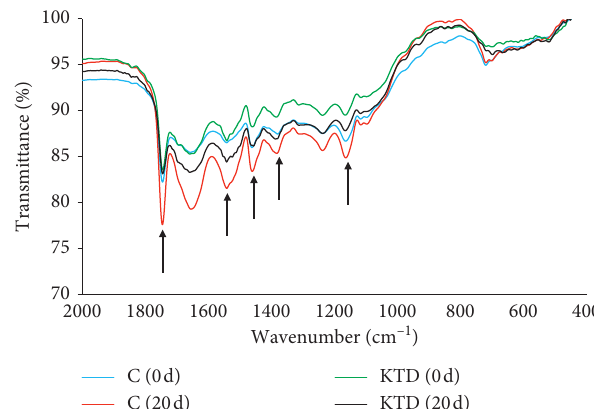
Figure 1: FTIR spectra of control (C) and CTCECS (KTD) samples during